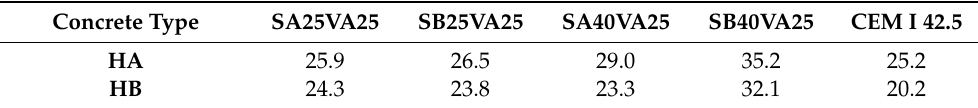
Table 7. Carbonation depth (mm) estimated for 50 years (XC3 environment defined in Table 2). Concrete